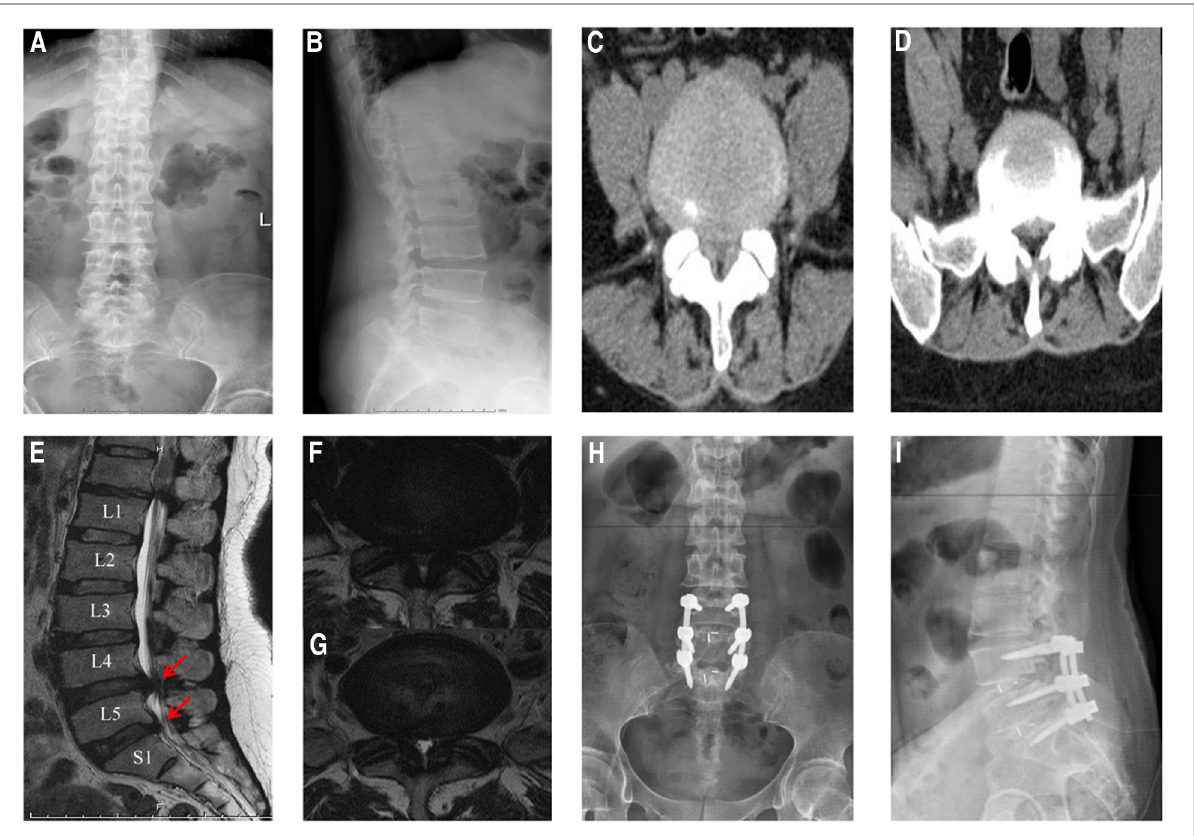
FIGURE 1 A representative case of posterior fusion surgery. ( A,B ) Preoperative x-ray radiographs; ( C,D ) preoperative CT scans of L4-5 and L5-S1, respectively; ( E ) preoperative MRI scan (sagittal plane); ( F,G ) preoperative MRI scans of L4-5 and L5-S1, respectively (axial plane); ( H,I ) postoperative x-ray radiographs. The arrows indicate the herniation of intervertebral